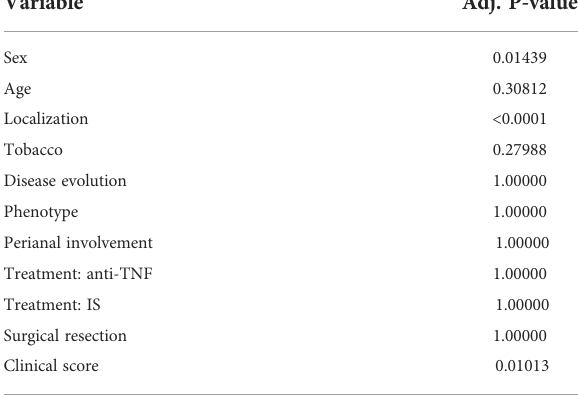
TABLE 1 Multiple linear regression to assess associations between clinical parameters of CD and IL-22BP